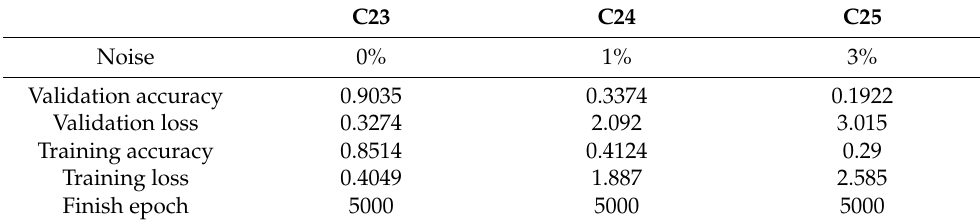
Table 11. Burst location results considering distinct measurement noise levels.